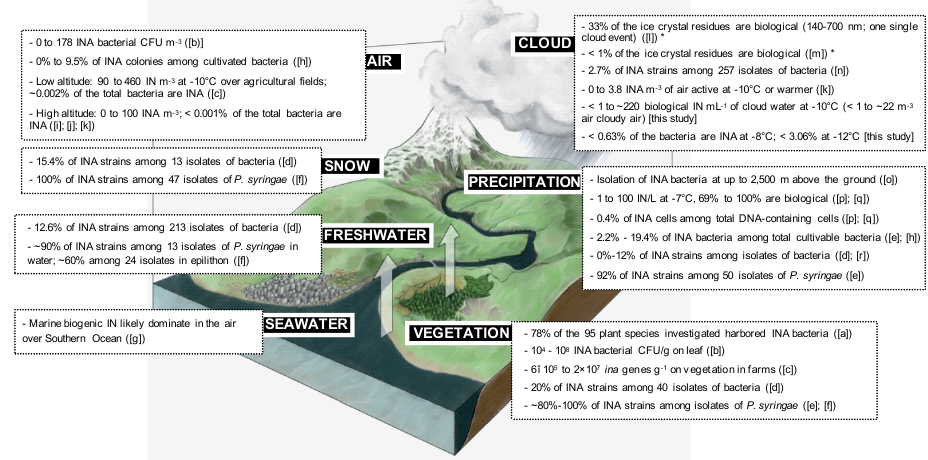
Figure 1. Schematic summarizing our current knowledge about the abundance of biological IN active at temperatures ≥ − 10 ◦ C in the dif- ferent environmental links of the water cycle. An asterisk indicates data relative to ice crystal residues in clouds at much colder